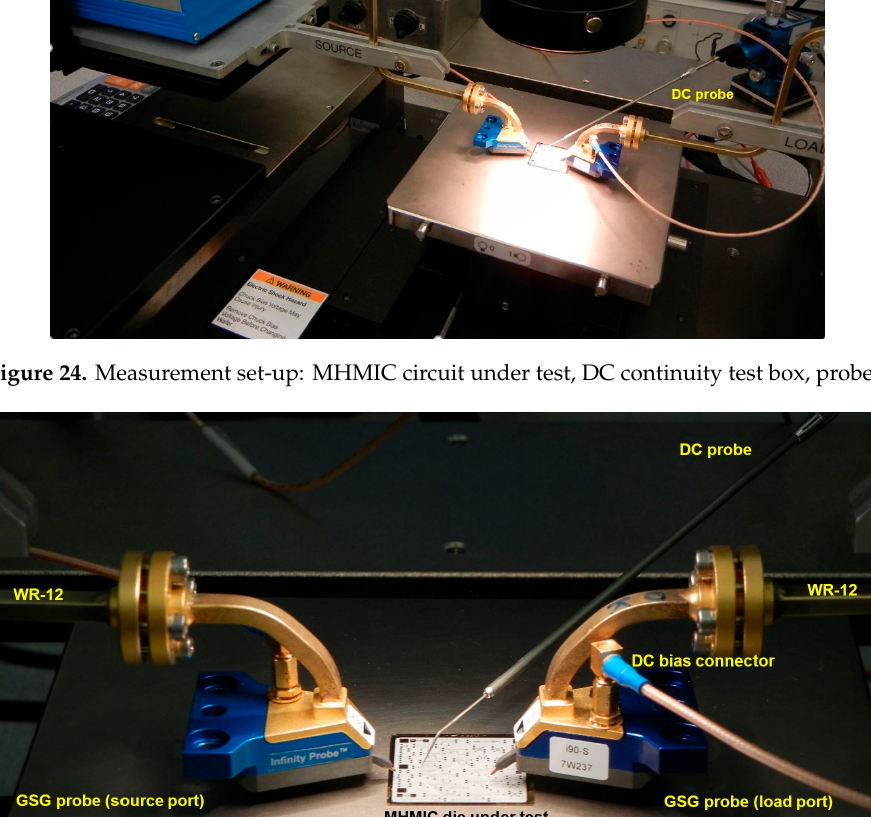
Figure 25. Details of measurement set-up: MHMIC circuit under test, GSG and DC probes.